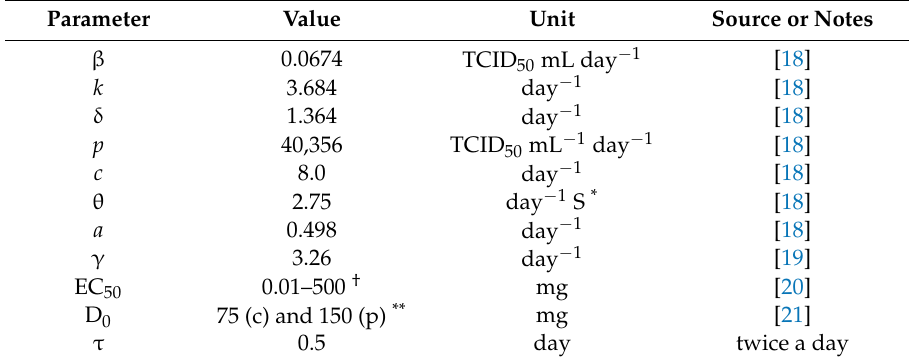
TCID 50 : 50% Tissue culture Infective Dose, * the symptoms score units; ** the curative (c) and pandemic (p) dosage regimen. † Consider the half-maximal concentration ranging from